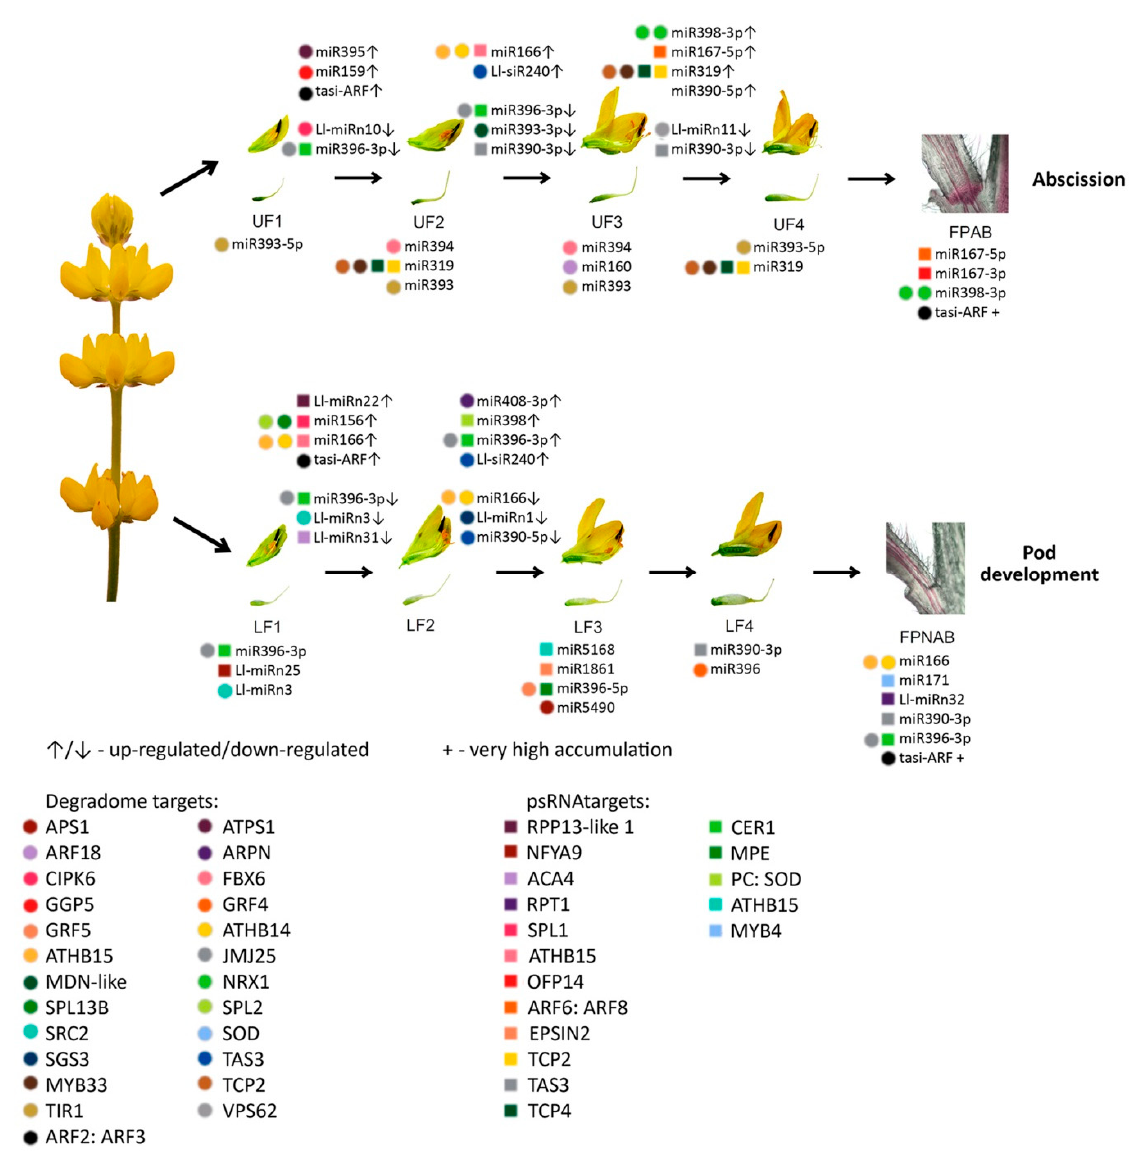
Figure 11. MiRNAs and siRNAs participating in yellow lupine flower development and abscission. Scheme based on the results of the current analysis. Arrows pointing upwards and downwards represent sRNAs that are up or downregulated in the transition between two developmental stages, respectively. The plus sign marks significantly expressed sRNAs. Colored circles represent targets found in the degradome, colored squares represent targets found using psRNATarget, as listed below. Multiple markers indicate that the sequence has multiple targets. Abbreviated gene names were acquired from UniProt database, where full target names can be found. Pictures from left to right are as follows: 4-whorl inflorescence of yellow lupine, flower cross-sections and isolated pistils for each stage of development, cross-sections of abscissing and non-abscissing flower pedicels stained with phloroglucinol-HCL solution.